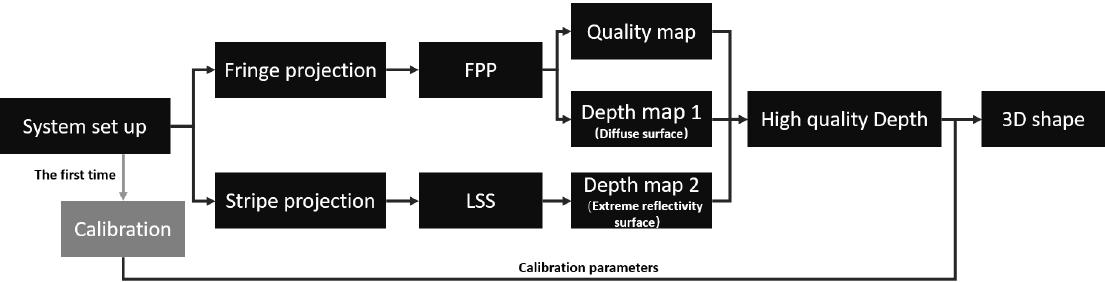
Figure 5. Flow chart of the proposed hybrid measurement